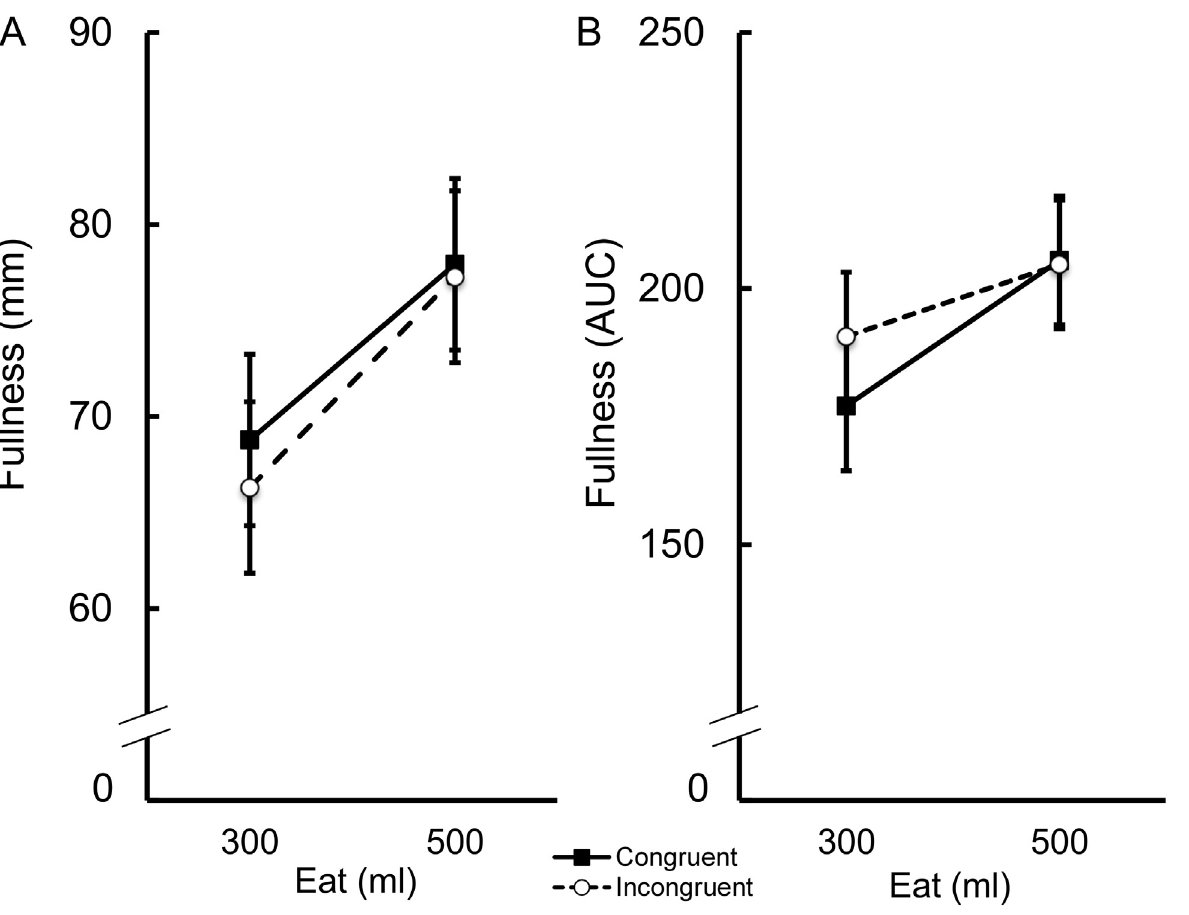
Fig 3. Mean ( ± S . E .) fullness composite scores immediately after eating (Panel A) and for an hour after eating (AUC; Panel B) the test foods. Separate values are provided for participants in each